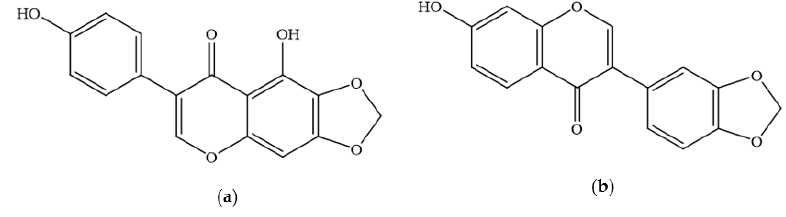
Figure 1. Basic Isoflavone structure.